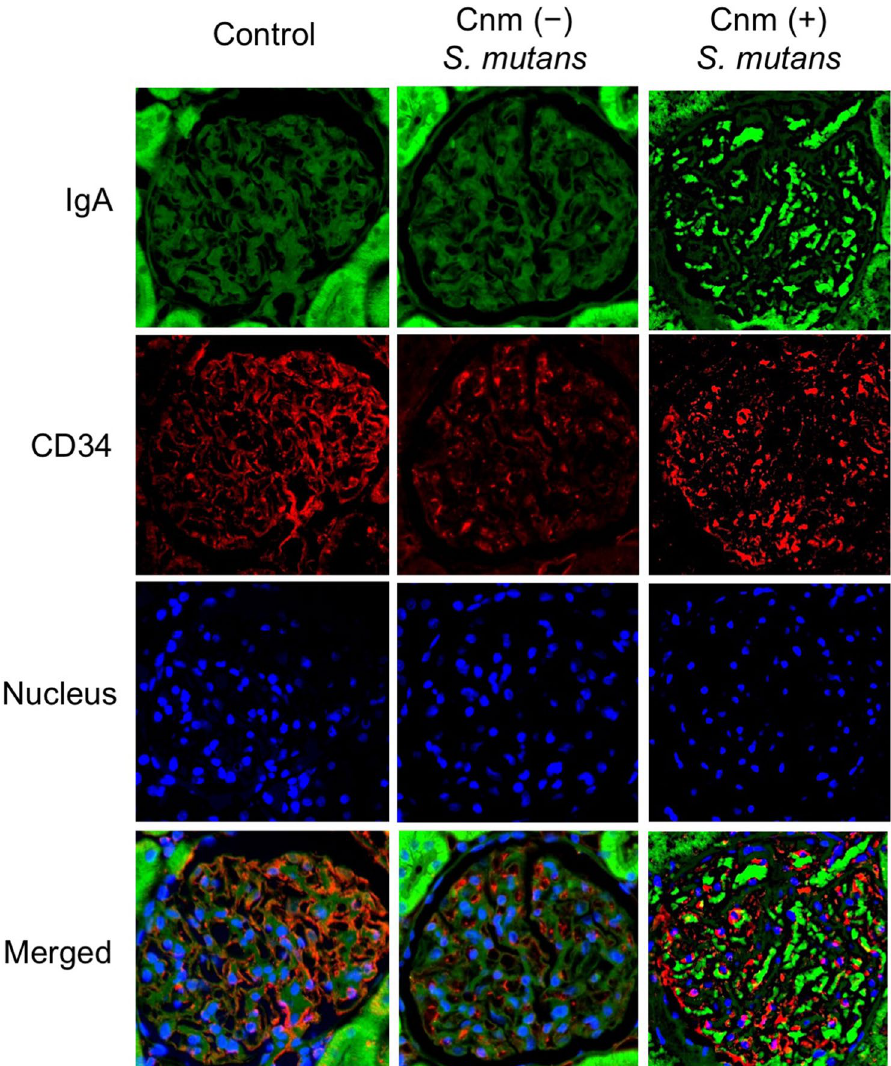
Figure 2. Representative histopathological appearance of kidney tissues by immunohistochemistry with an IgA-specific antibody. The first image shows staining with an anti-IgA antibody. The second image shows staining with an anti-CD34 antibody. The third image shows nuclear staining. The fourth row of images is superpositions of the top three